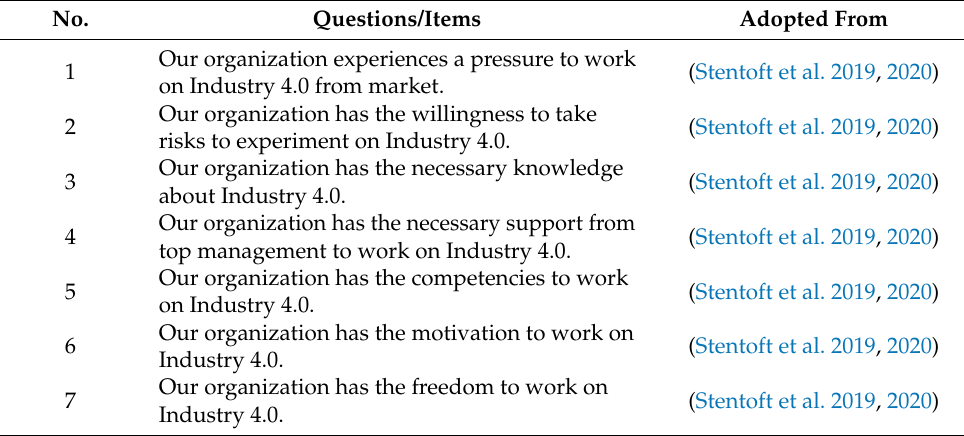
Table 1. Measurement for Industry 4.0